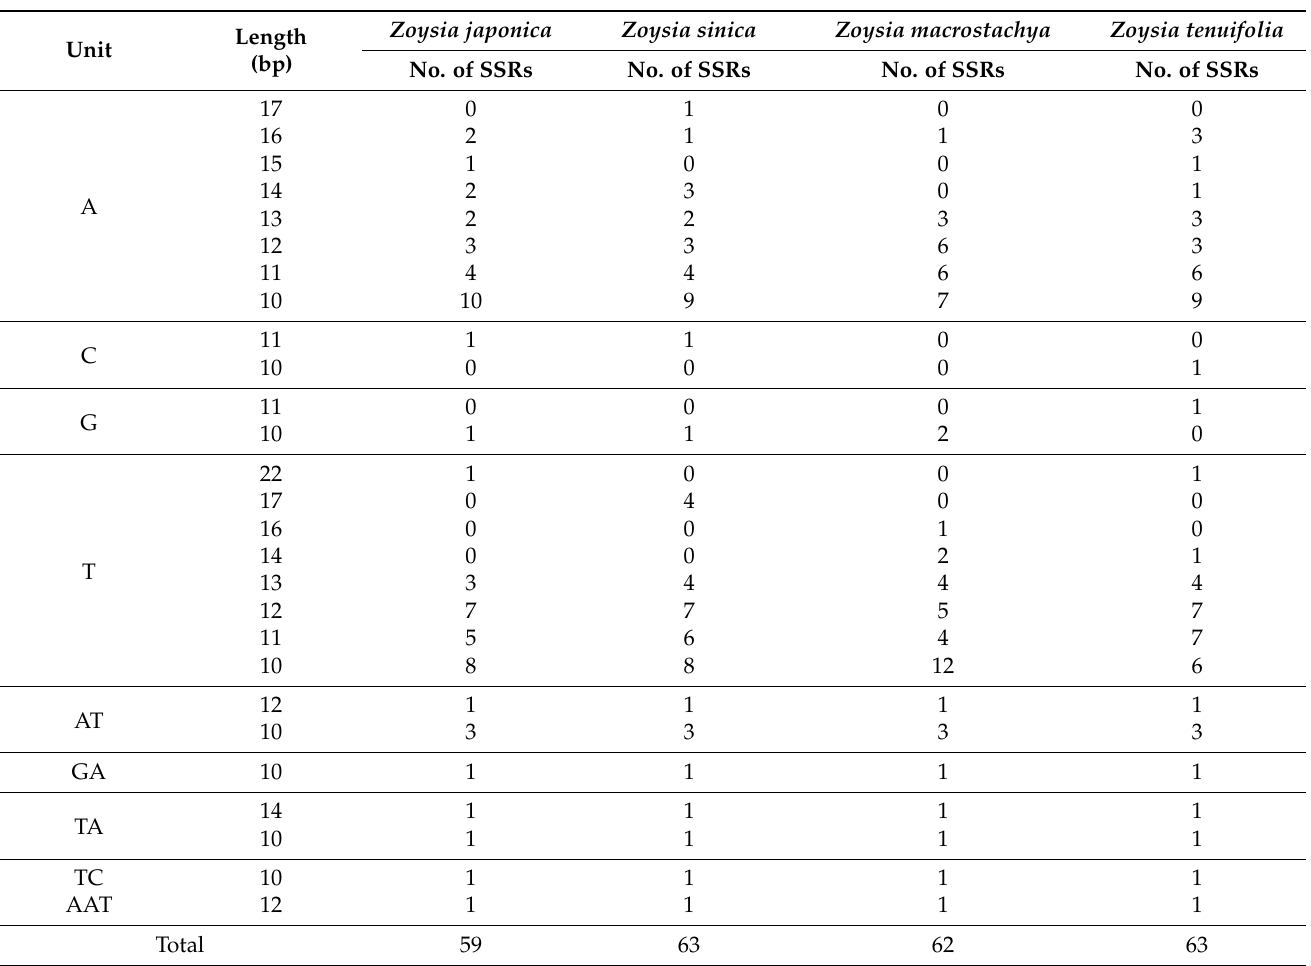
Table 3. Distribution of simple sequence repeats (SSRs) among the plastomes of Zoysia japonica , Z. sinica, Z. macrostachya , and Z. tenuifolia